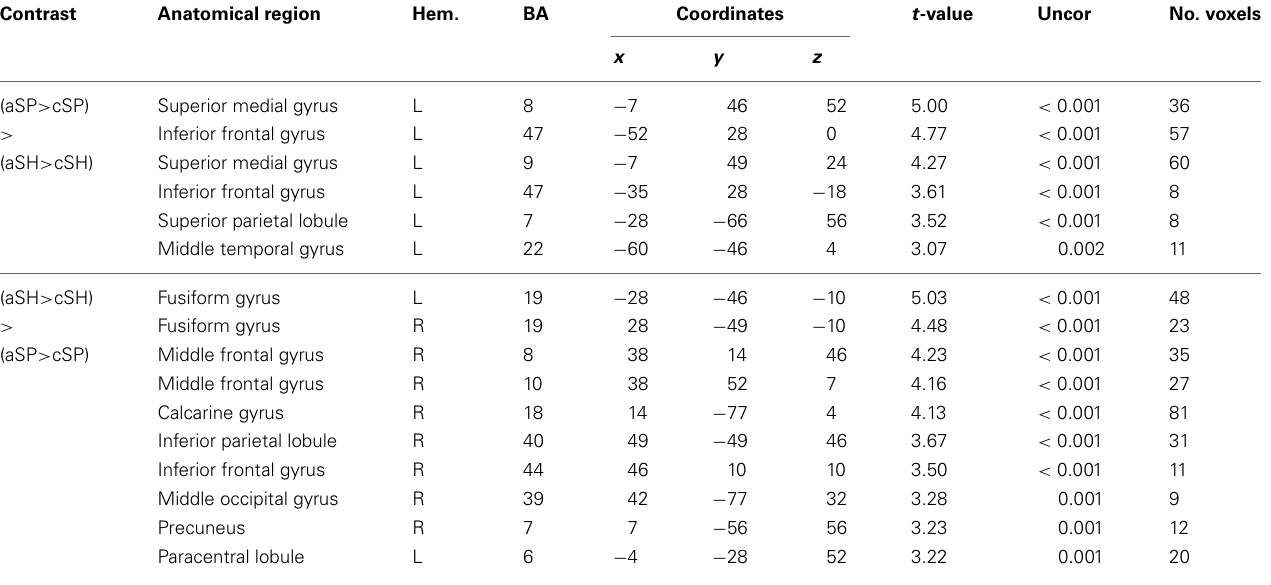
Table 6 | Interaction of semantic categories and